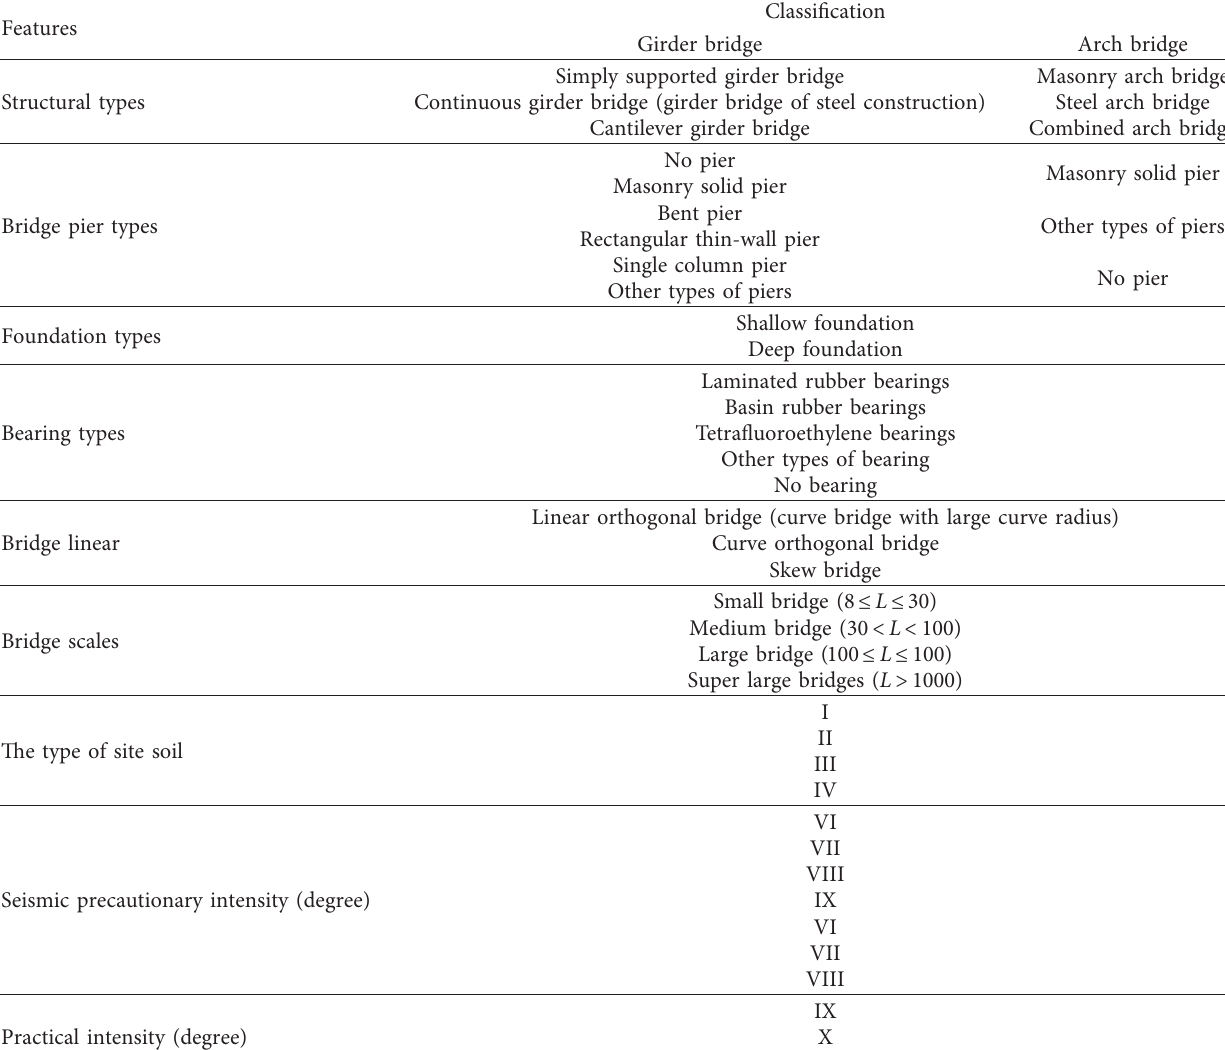
Table 2: Features table of the girder bridge and the arch bridge ( L is the length of the bridge